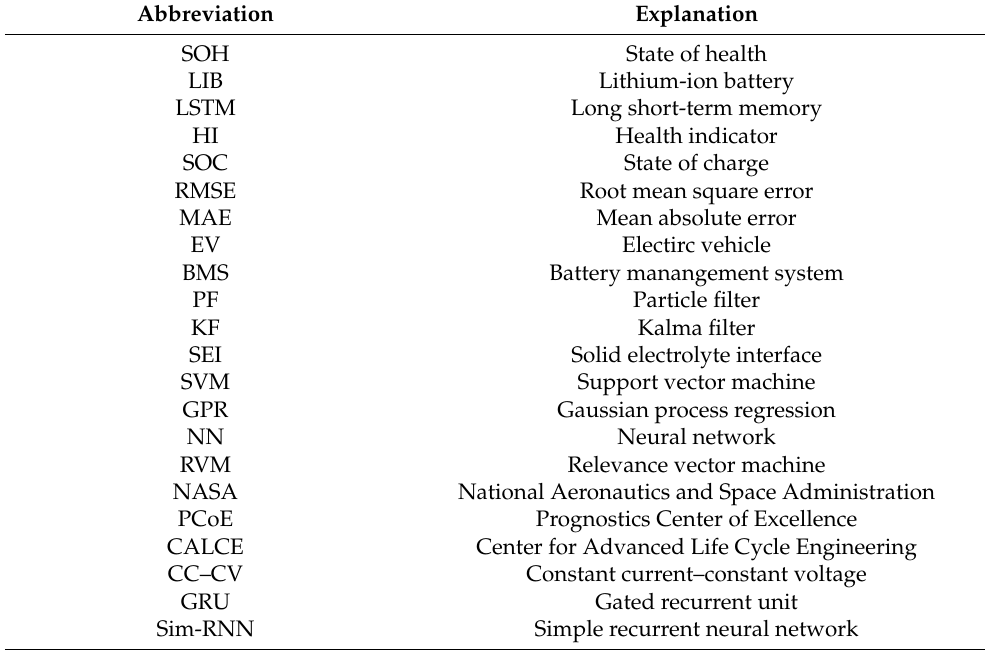
Table A1. Abbreviation comparison